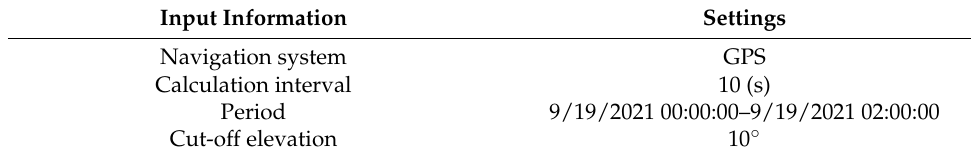
Table 1. Configuration of the parameters for the simulated PPP and integrity risk evaluation.